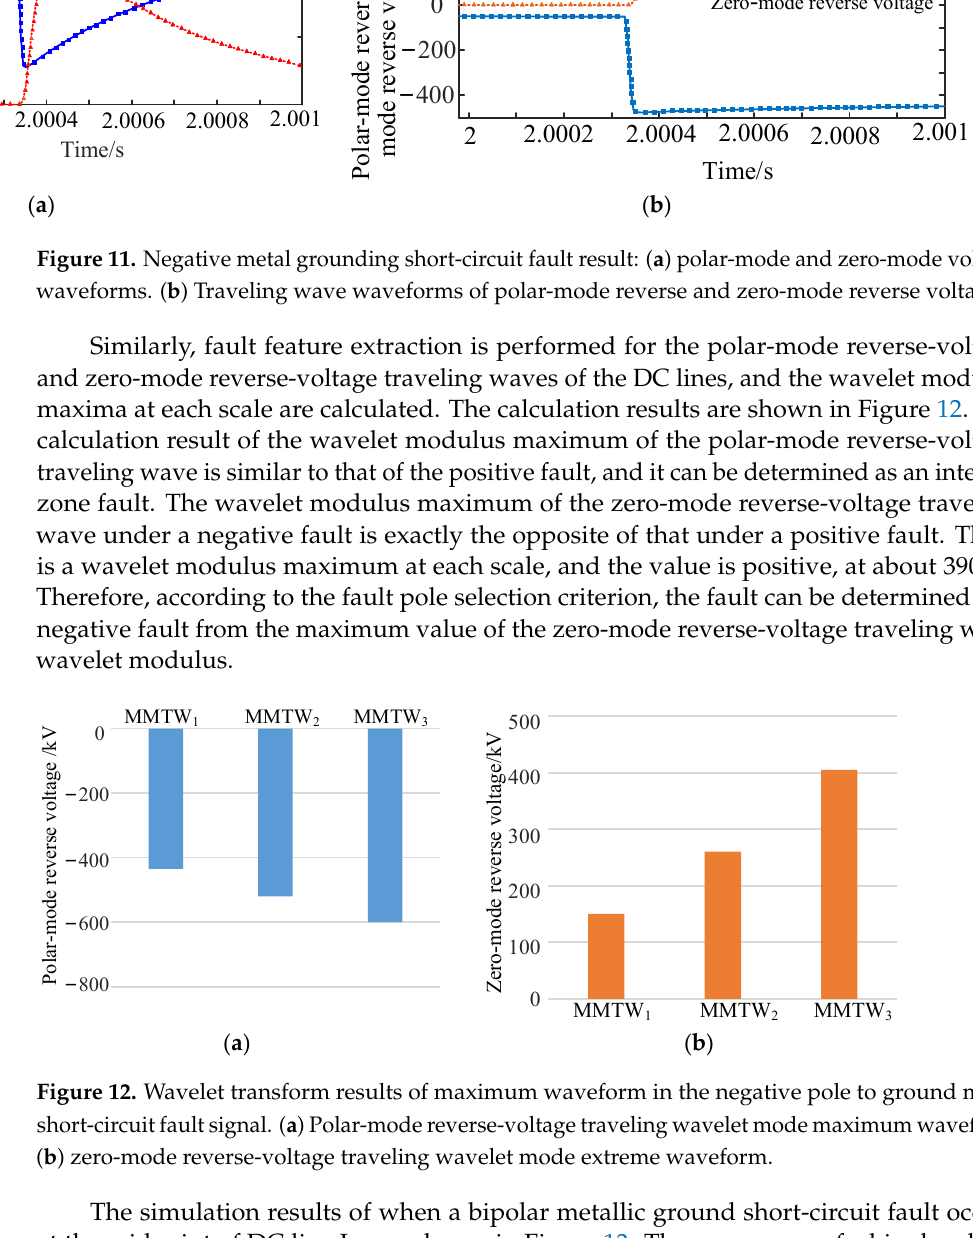
( b ) Figure 10. Wavelet transform results of maximum waveform in the positive pole to ground metal short ‐ circuit fault signal. ( a ) Polar ‐ mode reverse ‐ voltage traveling wavelet mode maximum wave ‐ form; ( b ) Zero ‐ mode reverse ‐ voltage traveling wavelet mode extreme waveform. Figure 11a illustrates that when the negative ‐ fault traveling wave reaches R1, the po ‐ lar ‐ mode voltage of the DC line is similar to the positive fault. Both the polar ‐ mode volt ‐